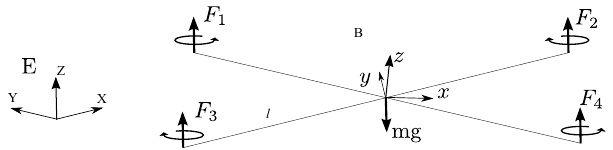
Figure 3. Quadrotor configuration. B represents the quadrotor fixed frame and E the inertial